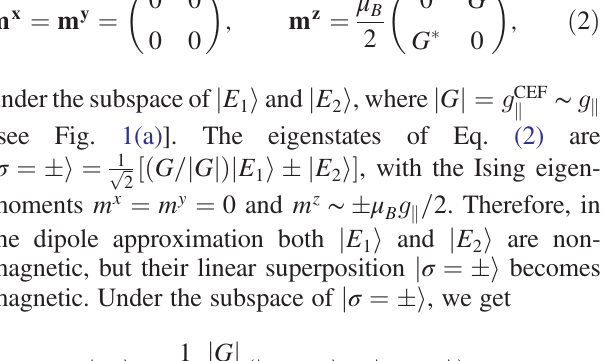
FIG. 2. Combined fits to the temperature dependence of (a) sus- ceptibility and (b) magnetic heat capacity measured at ∼ 0 T, as well as (c) the field dependence of magnetization measured at 40 mK, on the single crystal of TmMgGaO 4 , using models 0, 1, 2, 3, and 4, respectively (see main text). (d) Magnetic field depend- ence of structure factors measured on the selected magnetic reflections at 60 mK on D23. The colored lines present the calculatedvaluesperTm(multipliedby1800Tm,seeAppendixD) at60mKusingthe abovemodels1,2,3,and4.Models1and2give zero static structure factors on the magnetic reflections. (e) Magnetic entropy of TmMgGaO 4 measured at 0 T. The colored lines show the calculated values using models 3 and